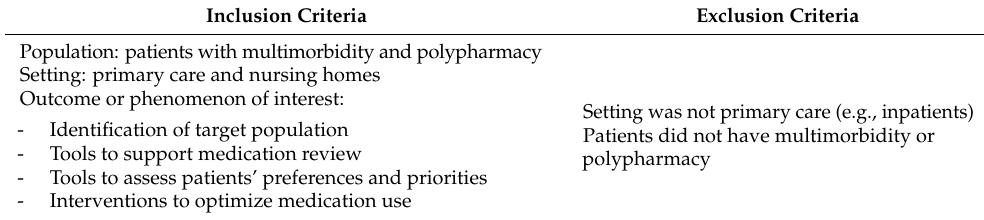
Table 2. Inclusion and exclusion criteria in the search for additional evidence.